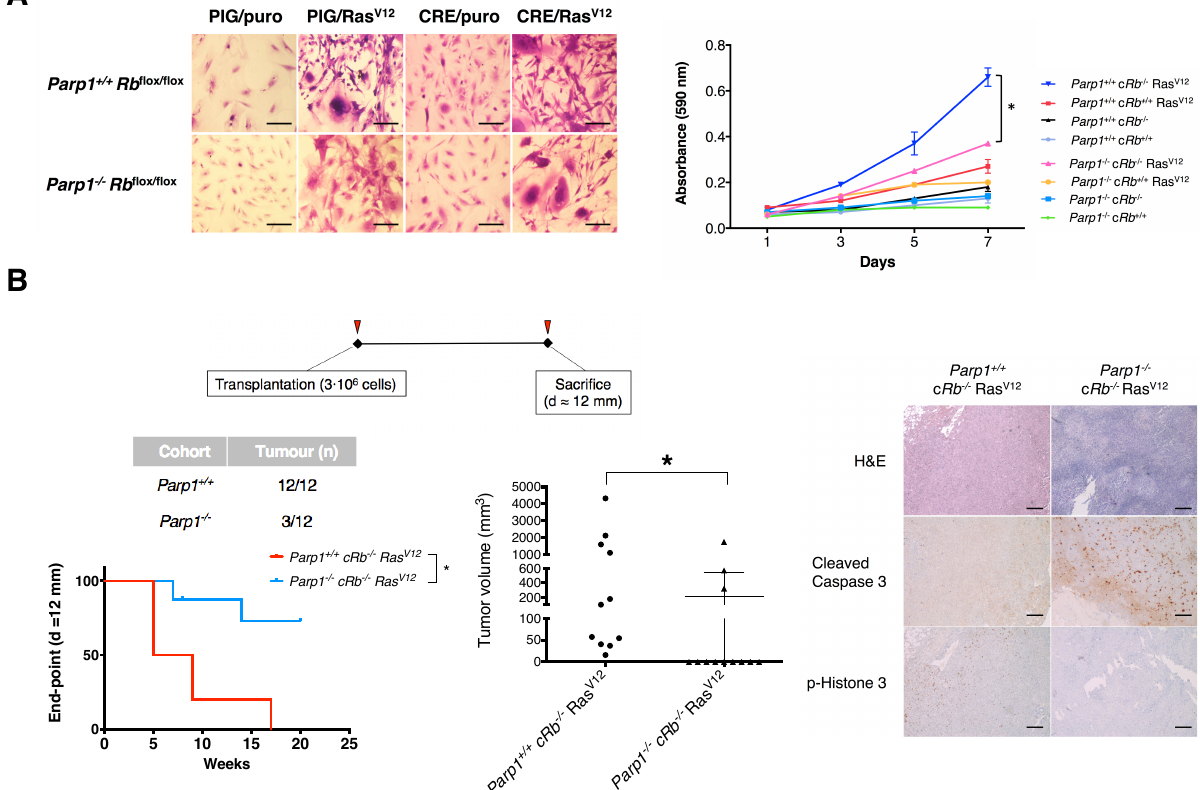
Figure 3. The absence of Parp1 leads to reduced oncogenic potential in transformed astrocytes and inhibition of tumour development in vivo. ( A ) Morphological changes and proliferation rates were evaluated in Parp1 +/+ c Rb − / − Ras V12 and Parp1 − / − c Rb − / − Ras V12 glial cells. Cells were stained with crystal violet and proliferation curves were calculated. Parp1 +/+ c Rb − / − Ras V12 glial cells showed a transformed phenotype when compared with control cells, characterized by the presence of prominent morphological changes and an increased proliferation. Scale (40 × ) = 25 µ m. This transformed phenotype is reduced in cells null for Parp1 (* p < 0.05). ( B ) The oncogenic potential in vivo of Parp1 +/+ c Rb − / − Ras V12 and Parp1 − / − c Rb − / − Ras V12 astrocytes was assessed by injecting 3 × 10 6 cells in the hindquarters of SCID mice. All mice from the Parp1 +/+ c Rb − / − Ras V12 cohort developed tumoral masses, but only 3 out of 12 mice injected with Parp1 − / − c Rb − / − Ras V12 cells. Mice were euthanized when the tumour reached a diameter of 12 mm. The graph shows the mean tumour volume in both experimental groups (* p < 0.05). Kaplan-Meier graph shows the di ff erent tumour end-points (d = 12 mm) for mice of both cohorts (* p < 0.05). Histological analysis of tumoral samples obtained from control and Parp1 -deficient cohorts. Scale (20 × ) = 50 µ